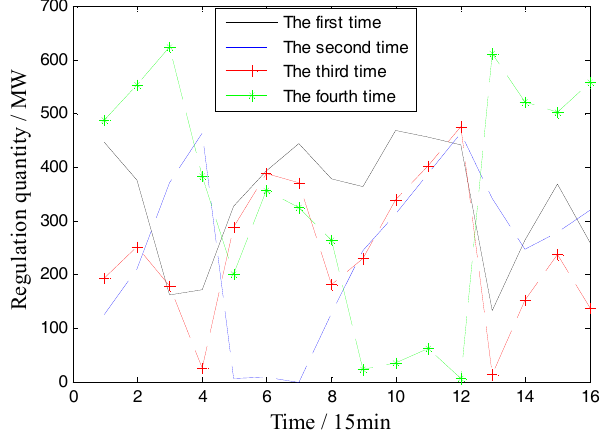
Figure 12. The output regulations for each period (Case 6).